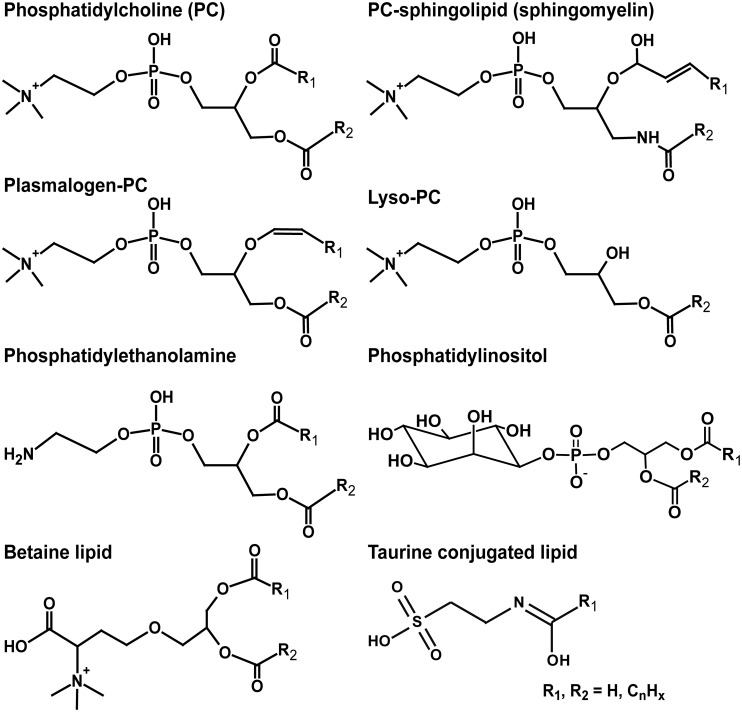
Structures of identified intact polar lipids in lipid extracts of animal tissues.PC = phosphocholine.